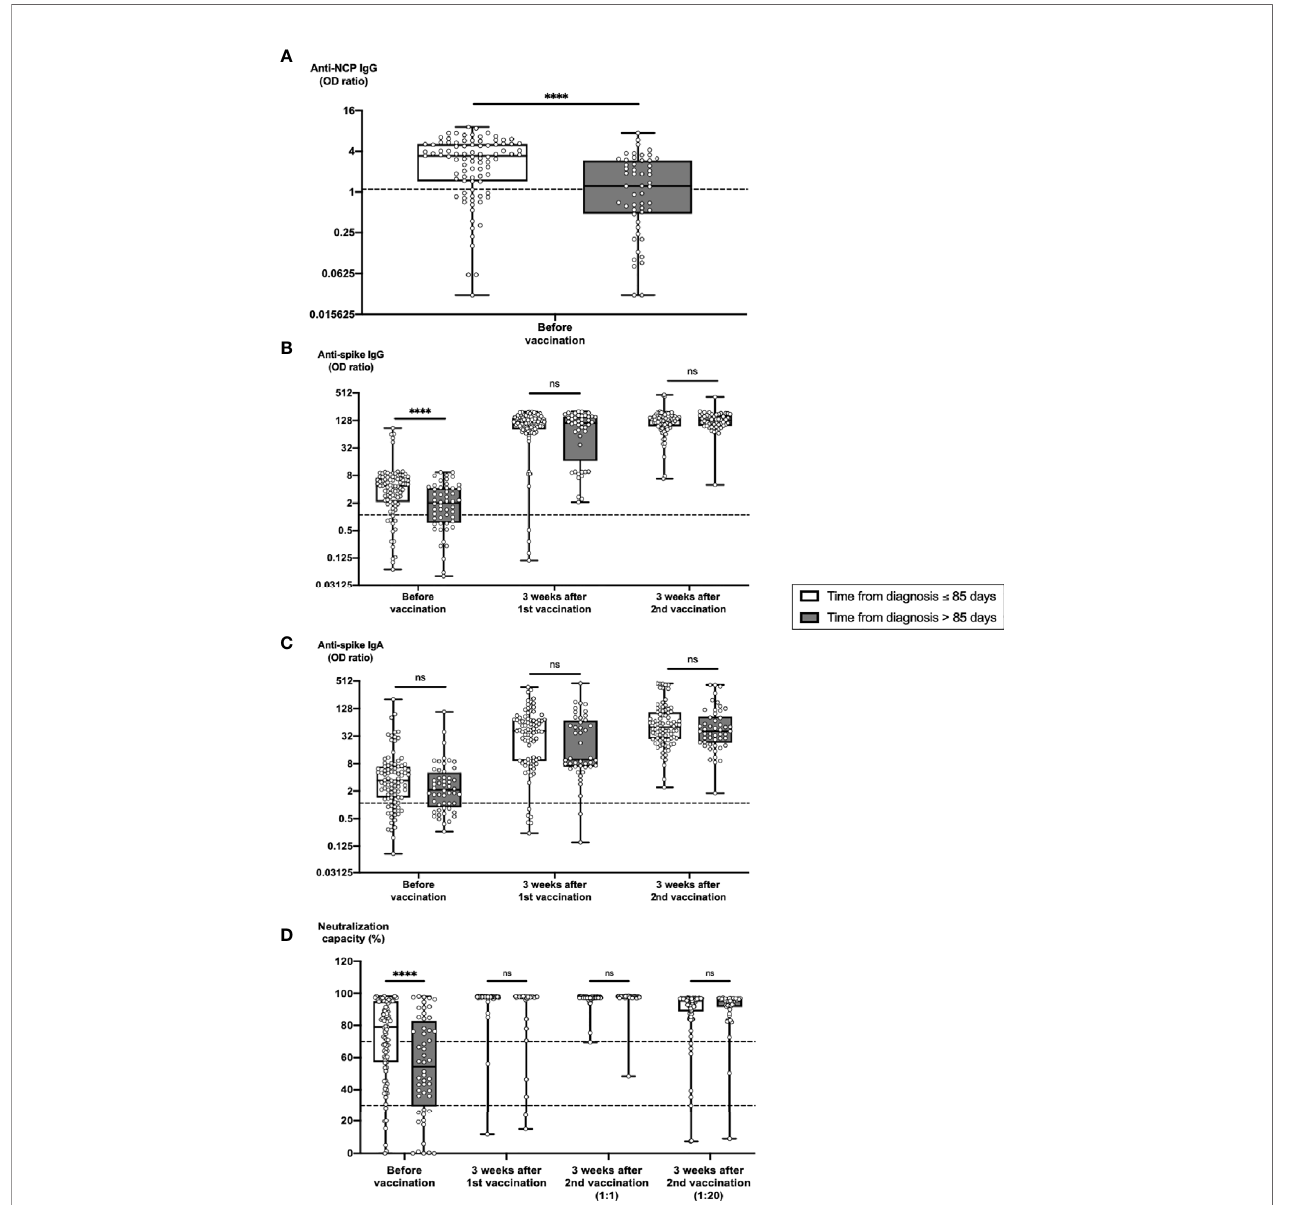
FIGURE 2 | Impact of time from COVID-19 diagnosis on the development of humoral immune parameters after vaccination. Serum samples from 91 subjects with a time from diagnosis ≤ 85 days and from 52 subjects with a time from diagnosis > 85 days were collected before vaccination, 3 weeks after fi rst vaccination and 3 weeks after second vaccination with BNT162b2. Samples were analyzed for anti-spike IgG and IgA titers, anti-NCP IgG titers as well as for ACE2-RBD neutralization capacities. Box blots show (A) anti-NCP IgG titers, (B) anti-spike IgG titers, (C) anti-spike IgA titers and (D) median neutralization capacities at different time points as indicated. Dotted lines indicate cutoff values. To further differentiate high neutralization capacities 3 weeks after second vaccination, an additional analysis using an extra serum pre-dilution of 1:20 was performed (blot pair on the right side in panel D). Box central horizontal lines indicate medians, box borders represent IQR, whiskers indicate minima and maxima. Signi fi cance level was ****p < 0.00005. ACE2, angiotensin-converting enzyme 2; IQR, interquartile ranges; NCP, nucleocapsid; ns, not signi fi cant; OD, optical density; RBD, receptor-binding